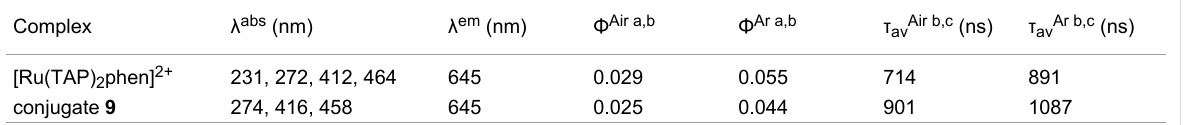
Table 1: Photophysical properties of conjugate 9 and [Ru(TAP) 2 phen] 2+ in water. Complex